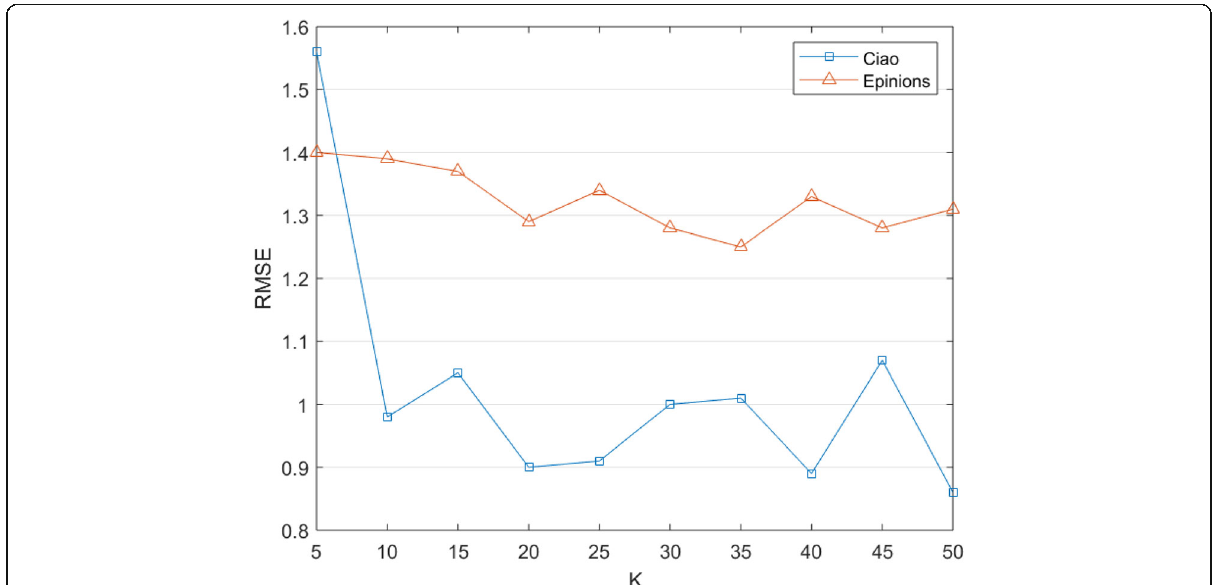
Fig. 8 RMSE vs. K on Ciao and Epinions. The blue line for Ciao, and the green line for